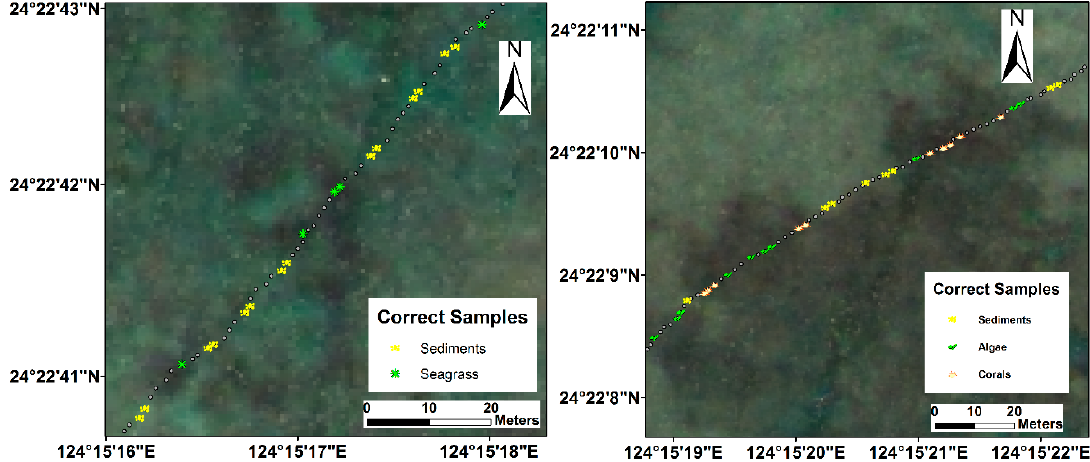
Figure 8. A sample of the correctly categorized and geo-located images along the field survey path used for benthic cover mapping over the Shiraho study area. Table 1. The OA and Kappa results of all methods for benthic habitats detection for Shiraho area.